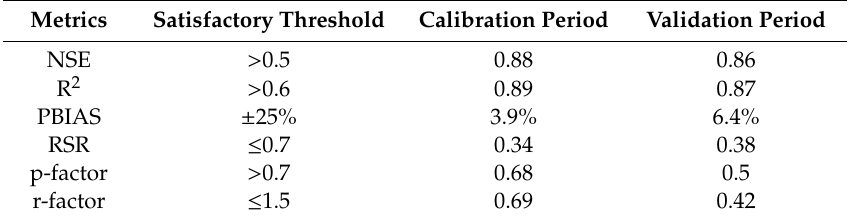
Table 5. Model e ffi ciency evaluation